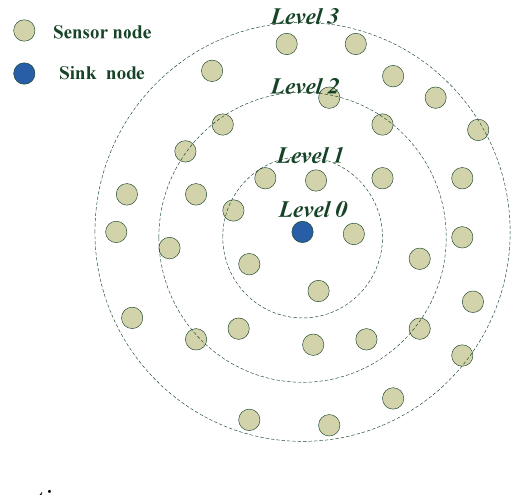
Figure 8. Result of level building when the sink node is in the